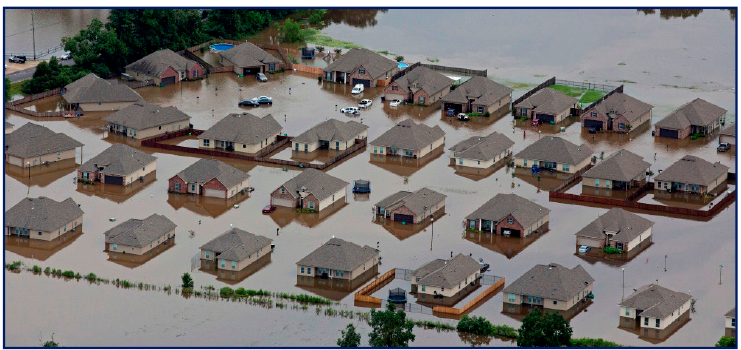
Figure 2. Flooded village [38] scenario where the fixed communication infrastructure is affected and WMNs could be used to establish connectivity among affected people and first